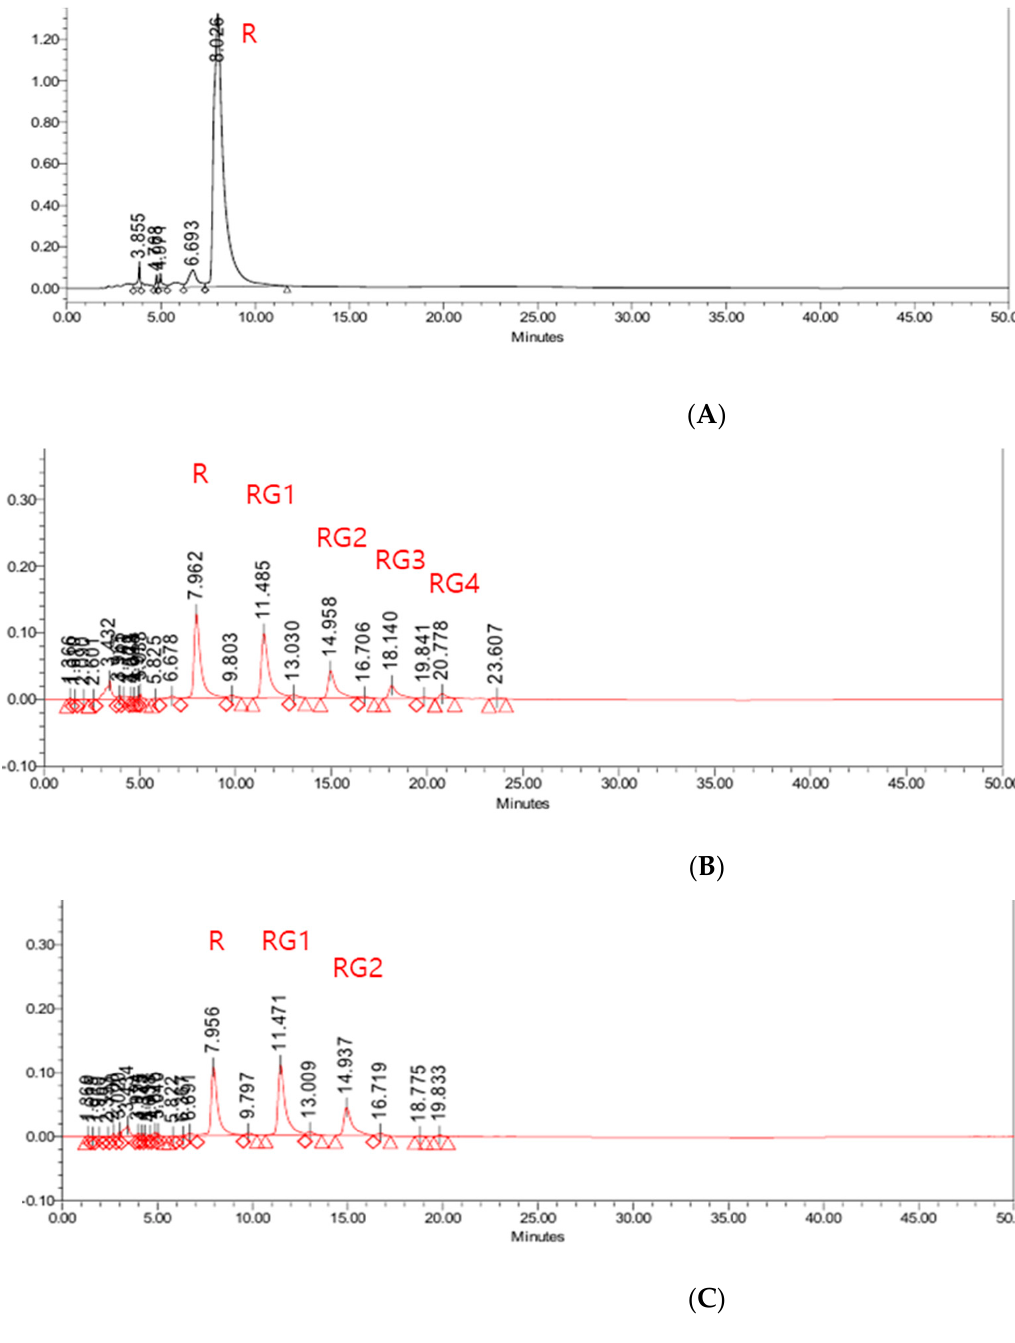
Figure 2. Rutin and rutin glycosides analyzed by HPLC during enzyme reaction. ( A ) Rutin before enzyme reaction, ( B ) rutin poly-glucosides after cyclodextrin glycosyl transferase (CGTase) reaction, ( C ) rutin mono-glucoside and rutin di-glucoside after β -amylase reaction. R; rutin, RG1; rutin mono-glucoside, RG2; rutin di-glucoside, RG3; rutin tri-glucoside, RG4; rutin tetra-glucoside.